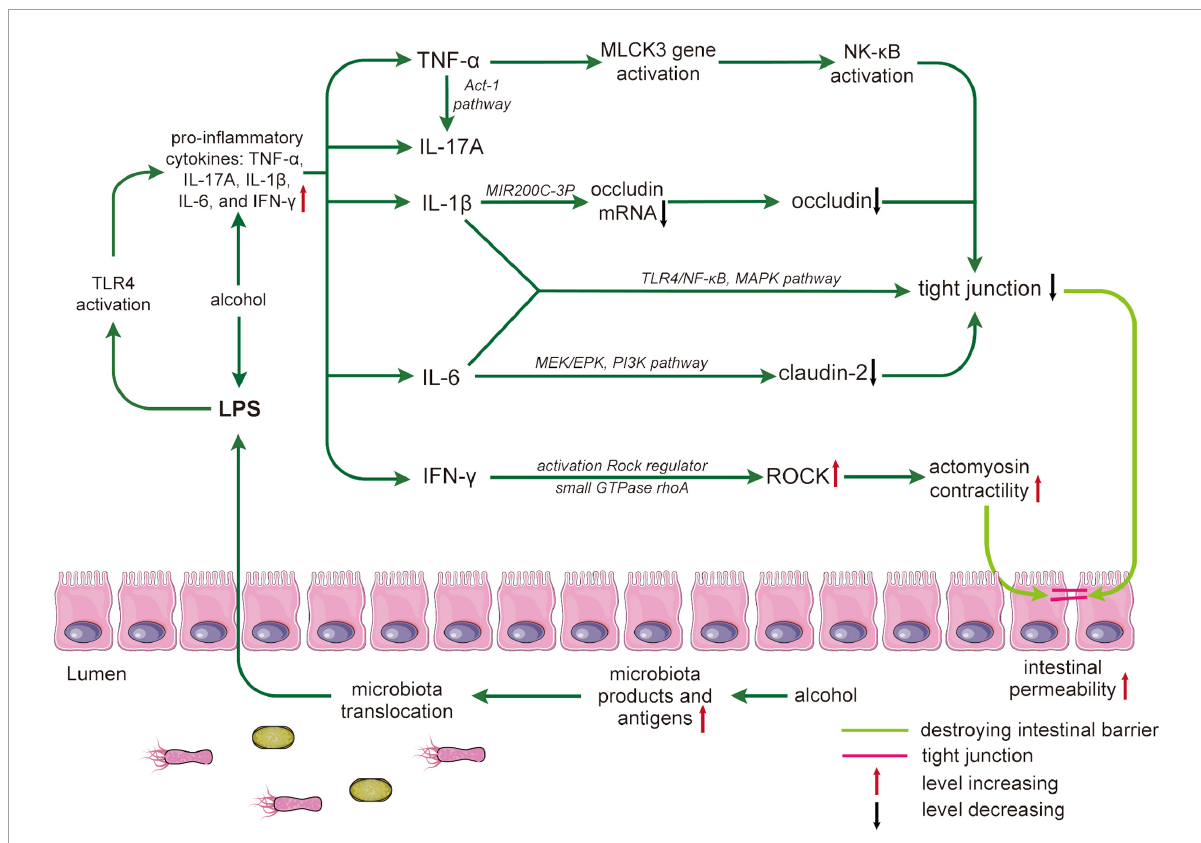
FIGURE2 Alcohol damages the intestinal barrier by mediating inflammatory cytokines. Alcohol leads to an increase in microbiota products and antigens, and microbiota translocation leads to an increase in lipopolysaccharides (LPS) crossing the intestinal barrier. LPS-activated toll-like receptor 4 (TLR4) results in increased proinflammatory cytokines that affect tight junction structure and expression. The process is as follows: tumor necrosis factor (TNF)- α promotes the activation of nuclear factor (NF)- κ B by activating the myosin light chain kinase 3 (MLCK3) gene and mediating the NLK/IKK- α axis; interleukin (IL)-17A increases TNF- α through the ACT-1 pathway. IL-1 β reduces occludin mRNA through miR200C-3p, resulting in a decrease in occludin. IL-6 reduces Claudin-2 through the MEK/EPK and PI3K pathways. Both IL-1 β and IL-6 directly affect the expression of TJs through the toll-like receptors 4 (TLR4), NF- κ B, and mitogen-activated protein kinase (MAPK) pathways. In addition, interferon (IFN)- γ regulates rho-associated coiled-coil containing kinase (ROCK) to cause tight junction destruction. Destruction and reduced expression of TJs can lead to increased intestinal permeability and ultimately to intestinal barrier disruption. LPS, lipopolysaccharides; MAPK, mitogen-activated protein kinase; MLCK, myosin light chain kinase; NK- κ B, nuclear factor-kappa B; ROCK, Rho-associated coiled-coil containing